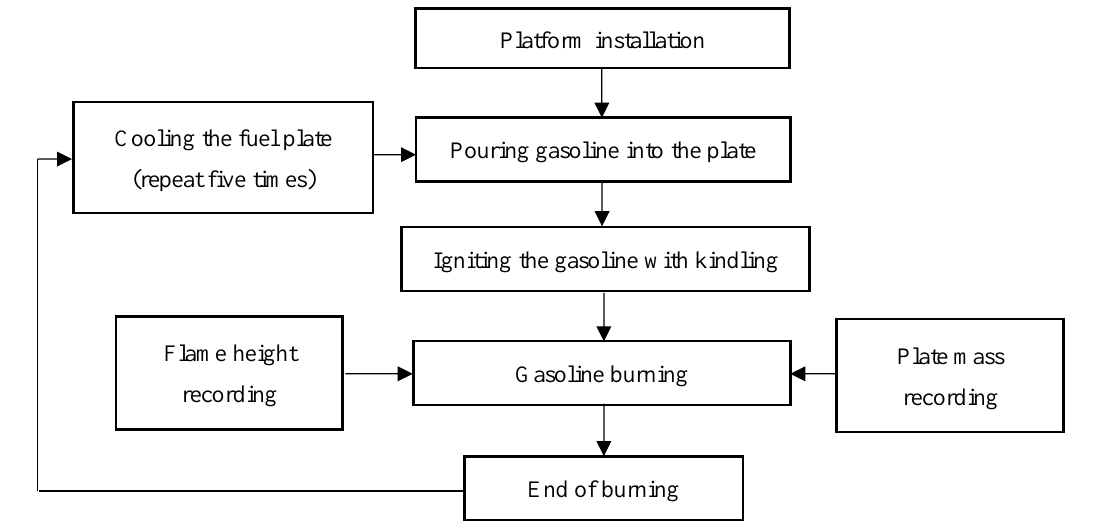
Figure 2. Process of burning experiments.